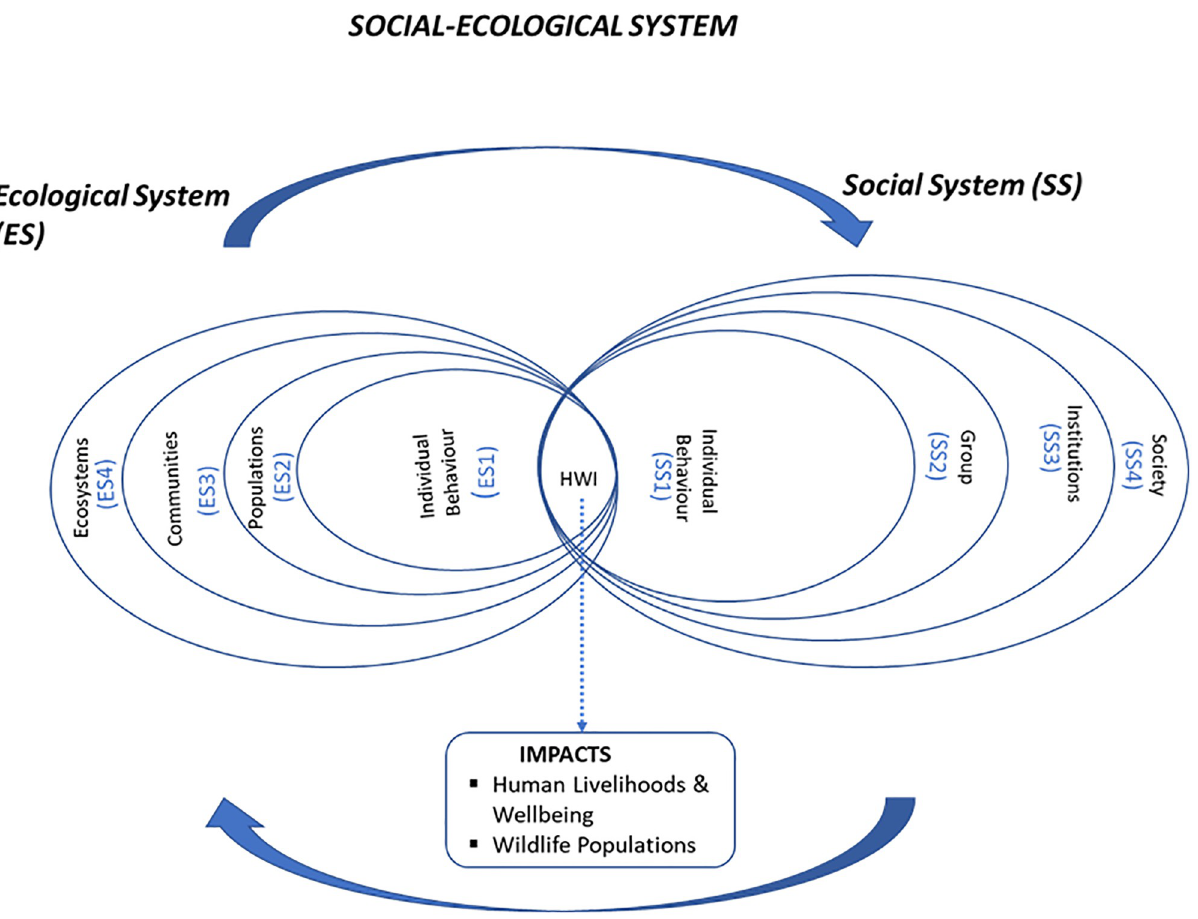
Fig 1. Conceptual framework for analyzing social-ecological systems and human-wildlife interactions (adapted from [15]).